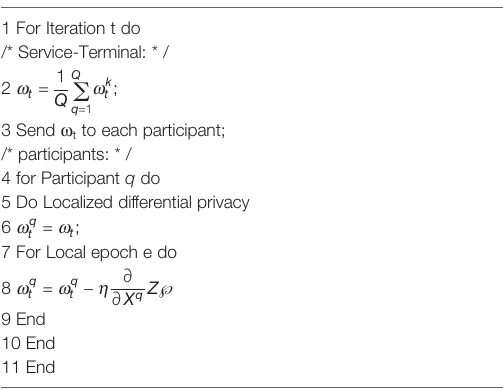
Algorithm 1 CNN-FL model based on local differential privacy